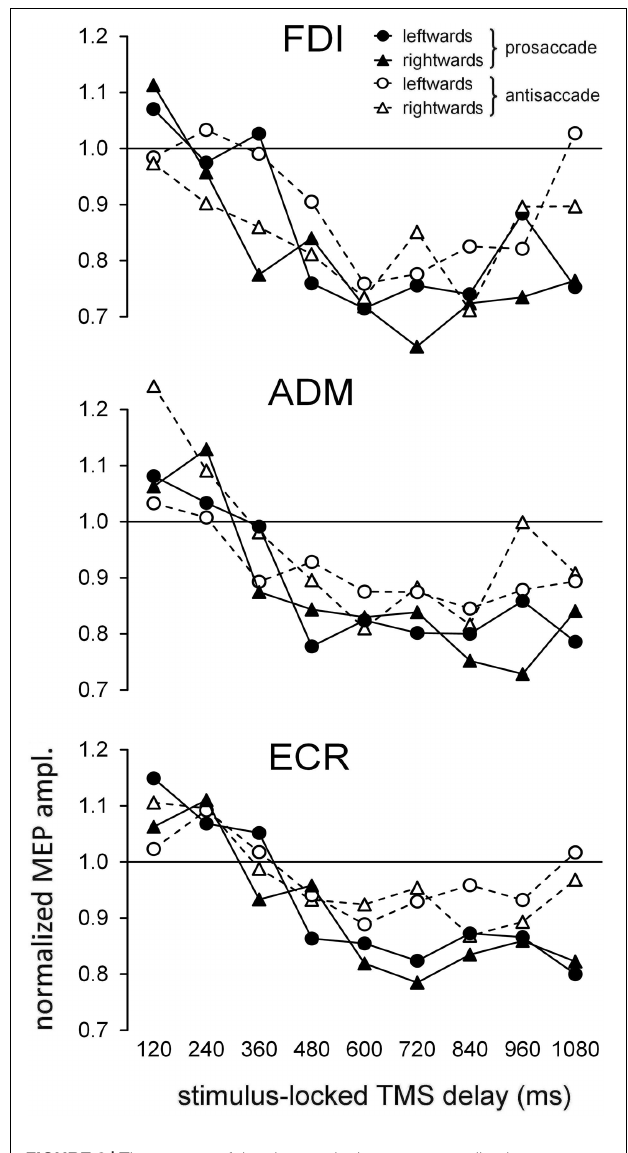
FIGURE 2 | Time course of the changes in the mean normalized motor evoked potential (MEP) amplitudes as a function of ocular task (‘prosaccade’/‘antisaccade’) and gaze direction (‘leftward’/‘rightward’). Graphs depict, separately for each recorded muscle, the data values as a function of the TMS delay with respect to the onset of the peripheral visual stimulus. Values higher than unity along the Y -axis indicate MEP amplitudes larger than